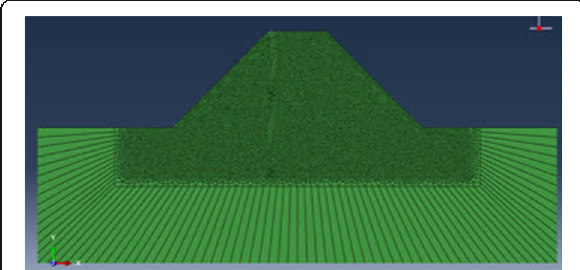
Fig. 6 2D model used for analysis ( SF =